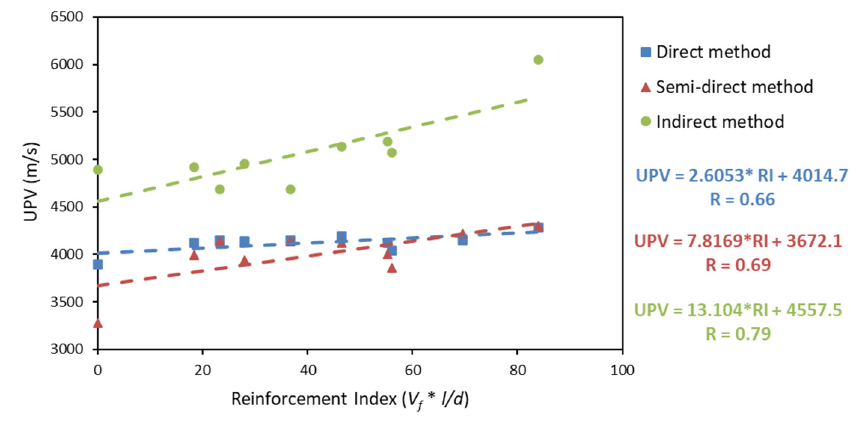
Figure 10. Correlation between the reinforcement index and ultrasonic pulse velocity.